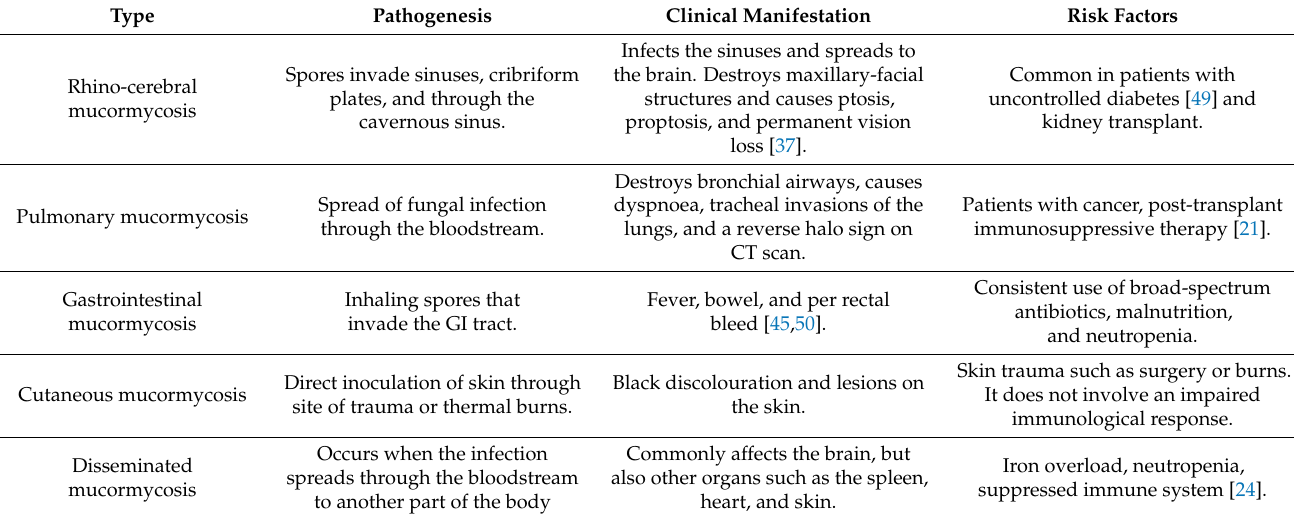
Table 1. Summary of mucormycosis clinical manifestations in COVID-19